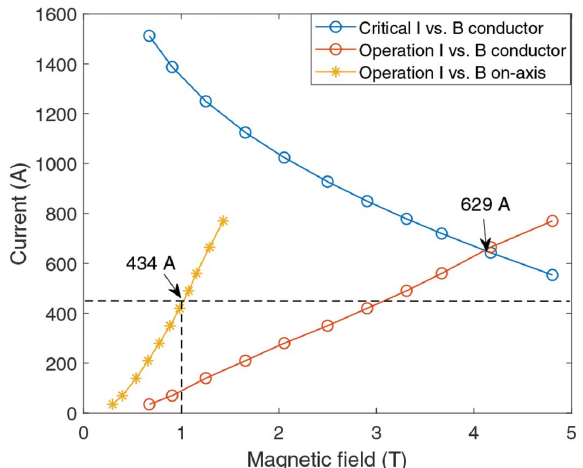
Figure 2 Operation currents (red) and critical currents (blue) with respect to the peak fields in conductors. The yellow points indicate the operation current versus the magnetic field on-axis. The maximum operation current is 629 A and the working current should be 434 A to reach the target peak field of 1 T.